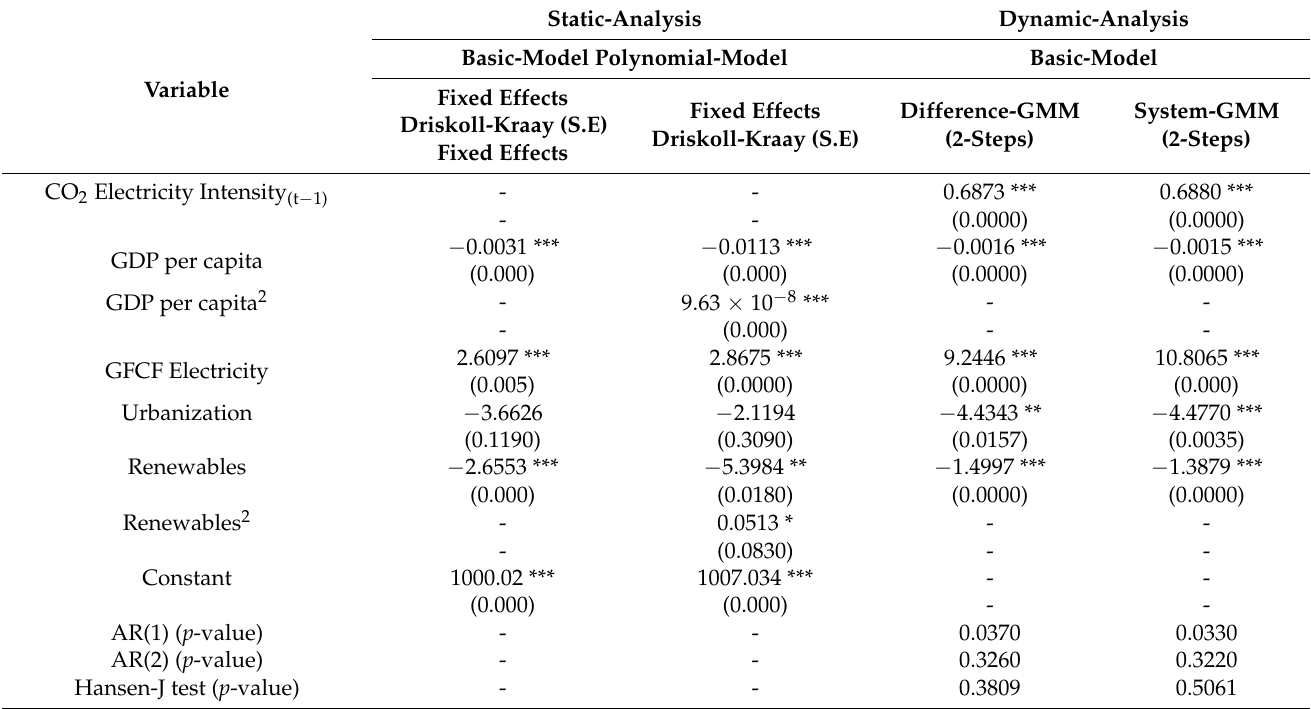
Table 12. Empirical findings under different